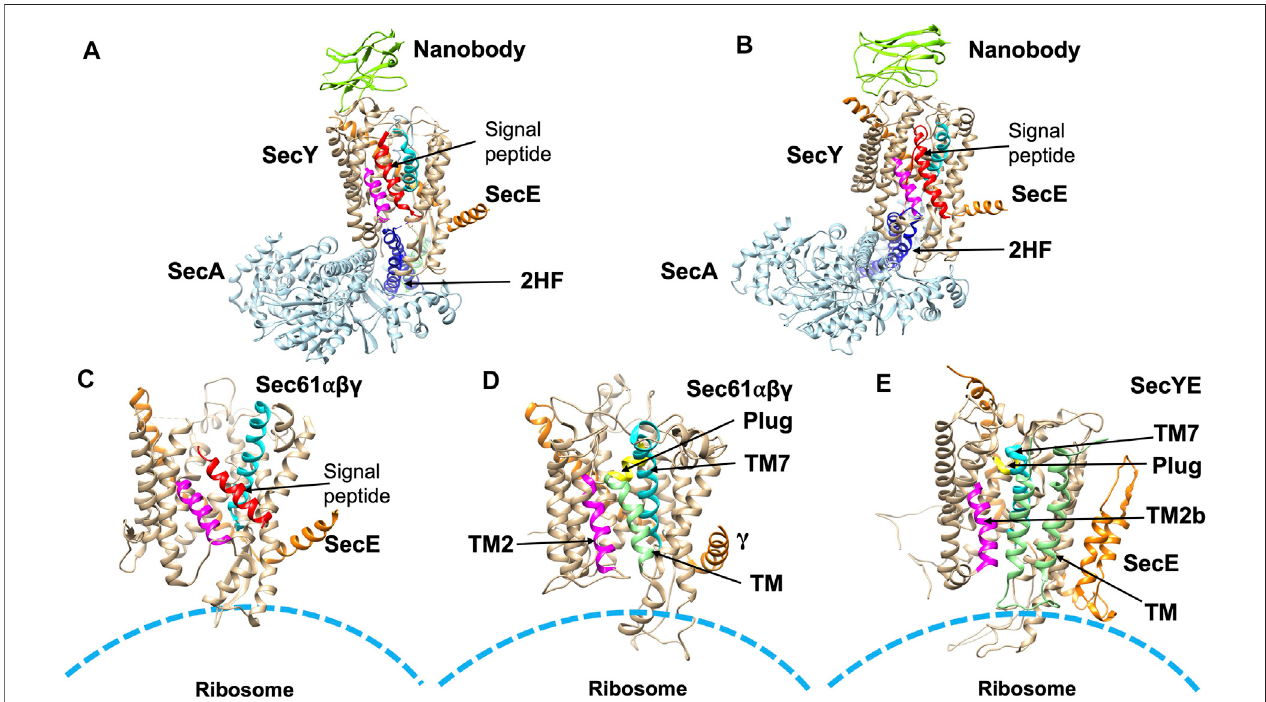
FIGURE 6 | Structures of substrate engaged SecYE or Sec61 complexes. (A) Crystal structure of SecYE-SecA [adapted from Li et al. (2016) PDB: 5EUL] with a portion ofthe preprotein (comprised ofthe OmpA signal sequence and a few residues in the mature region) fused into the 2HF (navy blue) by insertion between 741 and 744ofSecA.SecA(inlightblue)wasfrom B.subtilis andSecYEwasfrom Geobacillusthermodenitri fi cans .Nanobody(chartreuse)boundtotheperiplasmicsideofSecY (tan). (B) CryoEM structure of SecYEG-SecA complexed with a proOmpA sfGFP [adapted from Ma et al. (2019) PDB: 6ITC] fusion protein. The structure was performed with SecYE in a lipid nanodisc. An anti-GFP nanobody was inserted at the C-terminus of SecA to recognize and stabilize the fused sfGFP of the substrate. In addition,adisul fi dewascreated betweenacysteineatposition8intheearlymatureregionoftheproOmpA GFPfusionprotein andacysteineplacedintheplugdomain of SecY. Finally, a SecY nanobody that recognizes the periplasmic SecY region was added to stabilize the complex. SecA was from B. subtilis and SecYE was from Geobacillus thermodenitri fi cans . The nanobody is shown in green in (A,B) . (C) CryoEM structure [adapted from Voorhees and Hegde, 2016 PDB: 3JC2] in detergent of the canine ribosome Sec61 channel engaged with the N-terminal 86-amino acid preprolactin region. (D) CryoEM structure [adapted from Gogala et al. (2014) PDB: 4CG6] of the canine Sec61 channel engaged with a hydrophobic TM segment (light green) of a leader peptidase (lep) arrested intermediate. The TM segment was modeled within the opened TM2/TM7 lateral gate. (E) CryoEM structure (adapted from Bischoff et al. (2014) PDB: 5ABB) of a stalled E. coli ribosome SecYE complex engaged with proteorhodopsin (TM indicated in light green). TM2 and TM7 of the lateral gate are shown in magneta and cyan, respectively in (A – E) . The signal peptide (red) is indicated in (A – C) . The plug helix is indicated in yellow in (D,E) .